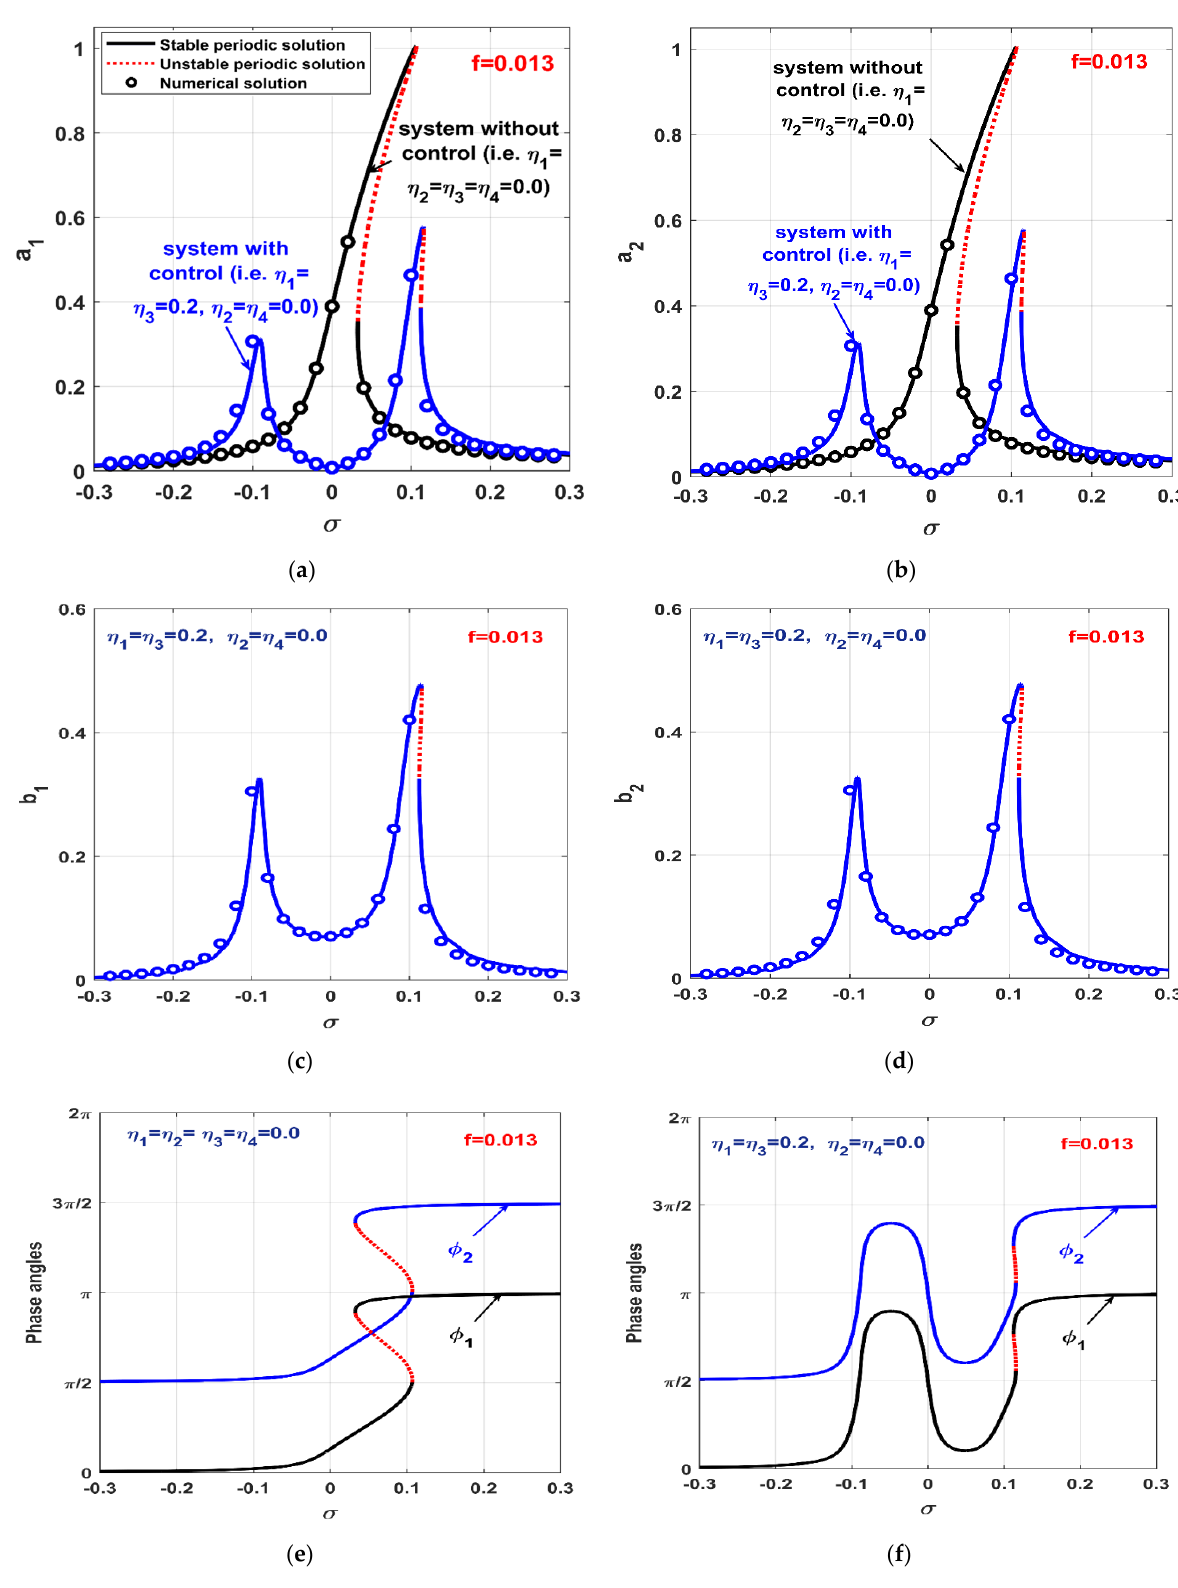
Figure 11. Vibration amplitudes and phase angles of the twelve-poles rotor in the case of both the 𝑃𝐷 -control only and the 𝑃𝐷 + 𝑃𝑃𝐹 -control algorithms, when 𝑓 = 0.013 : ( a , b ) vibration amplitudes ( 𝑎 (cid:2869) ,𝑎 (cid:2870) ) of the rotor, and ( c , d ) vibration amplitudes ( 𝑏 (cid:2869) ,𝑏 (cid:2870) ) of the 𝑃𝑃𝐹 -controller, ( e ) phase angles ( 𝜙 (cid:2869) ,𝜙 (cid:2870) ) when 𝜂 (cid:2869) = 𝜂 (cid:2870) = 𝜂 (cid:2871) = 𝜂 (cid:2872) = 0.0 , and ( f ) phase angles ( 𝜙 (cid:2869) ,𝜙 (cid:2870) ) when 𝜂 (cid:2869) = 𝜂 (cid:2871) = 0.2, 𝜂 (cid:2870) = 𝜂 (cid:2872) = 0.0 . Figure 11 compares the rotor dynamics in the case of both the 𝑃𝐷 - and the 𝑃𝐷 + 𝑃𝑃𝐹 -control algorithms, when the excitation force 𝑓 = 0.013 . The excellent correspond- ence between the numerical solutions (i.e., small circles) obtained by solving Equations (19)–(22) and the analytical solutions (i.e., solid and dotted lines) obtained by solving the algebraic system provided by Equation (74) is clear. In addition, the figure demonstrates that the coupling of the 𝑃𝑃𝐹 -control algorithm with the PD controller eliminated the strong vibration amplitudes of the rotor at the resonance condition (i.e., when 𝜎 → 0 ); however, two resonant peaks appeared on both sides of 𝜎 = 0 . Accordingly, we con- cluded that the 𝑃𝐷 + 𝑃𝑃𝐹 -control algorithm had high efficiency in eliminating the rotor’s undesired vibrations at the perfect resonance case (i.e., when 𝜎 = 0 or, in other words, when the angular speed Ω was equal to the system’s natural frequency 𝜔 , Ω = 𝜔 + 𝜎 ). However, if the resonant condition was lost (i.e., Ω ≠ 𝜔 ), the controller may pump exces- sive vibratory energy to the rotor system, rather than suppress it (see, for example, Figure 11a,b at 𝜎 = 0.1 ).